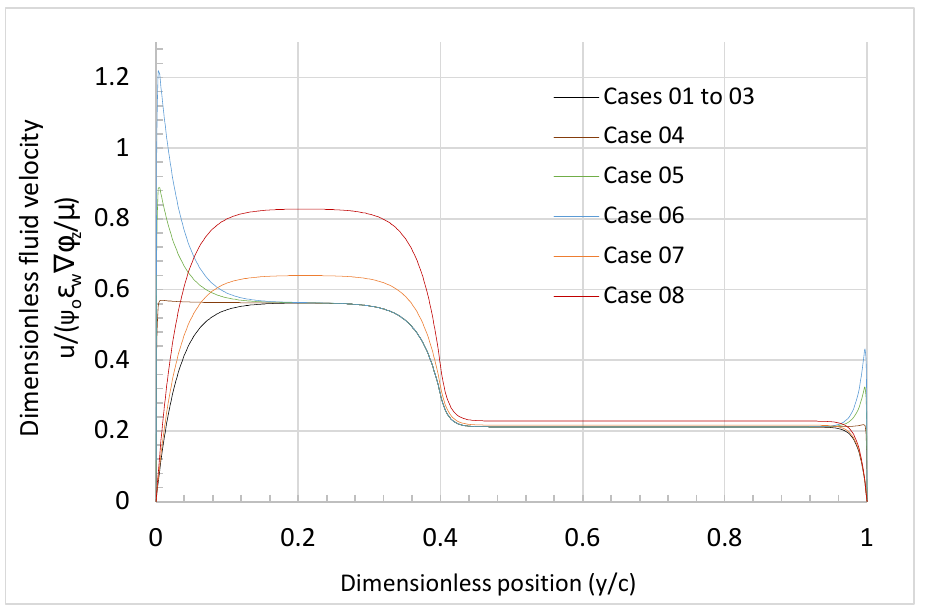
Figure 9. Dimensionless velocity in a parallel-plate channel. Double material. Table 4. Flow per unit section in a double-material parallel-plate channel.